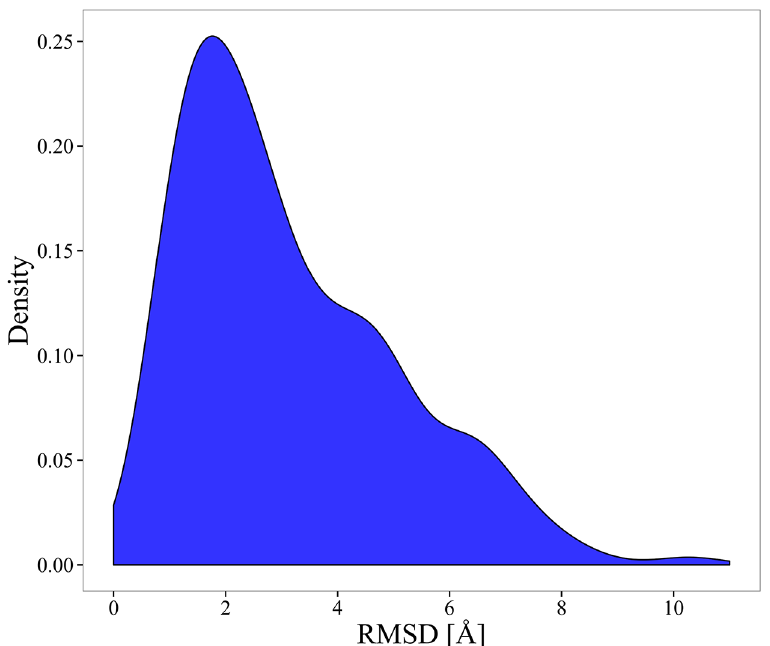
Fig 10. Distribution of the RMSD values over all pairs of ligand-free and ligand-bound conformations.